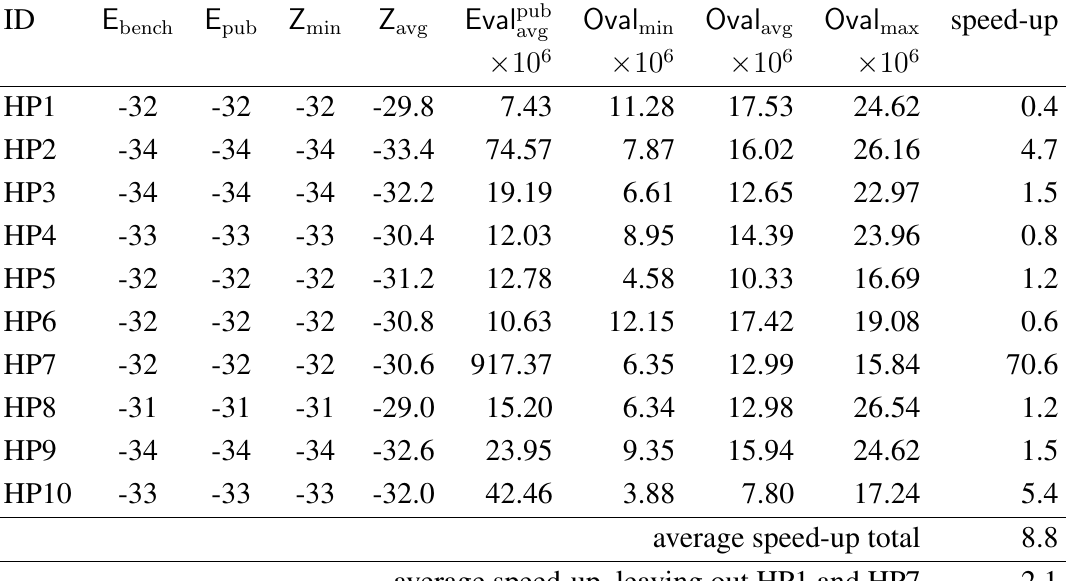
Table 4. Results for the H-P model on 3D cubic lattices for benchmarks from Table 1. Eval pub values are from the results published in avg